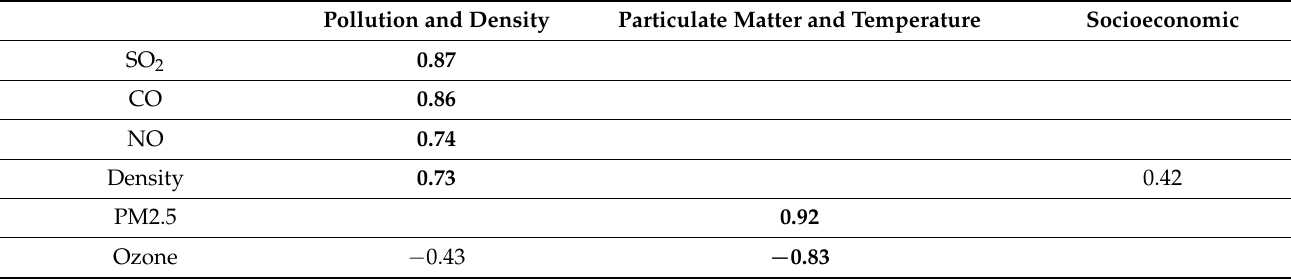
Table 2. Component